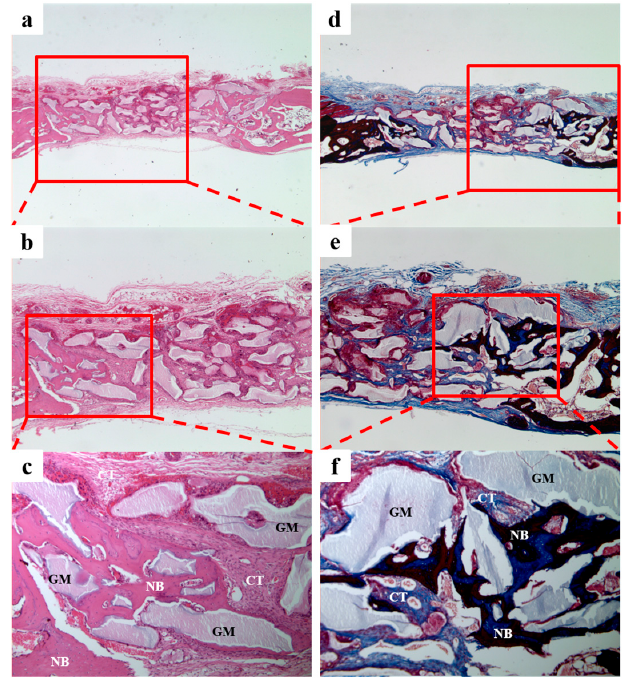
Figure 13. Histological sections of the BCP/HyA group at 4 weeks after surgery. A small amount of new bone formation and fibrous connective tissue were observed. NB, new bone; GM, grafted material; CT, connective tissue. H&E stain results ( a – c ); and Masson’s trichrome stain results ( d – f ) (original magnification: ×20 ( a , d ); ×40 ( b , e ); and ×100 ( c , f )).